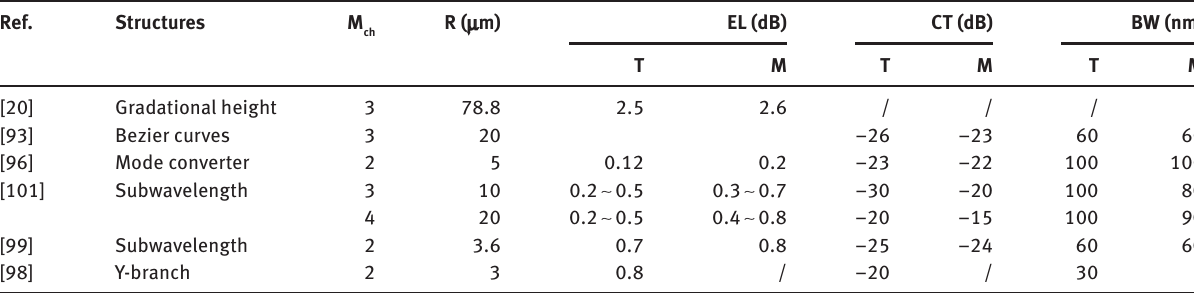
Table 2: Reported multimode waveguide bends.